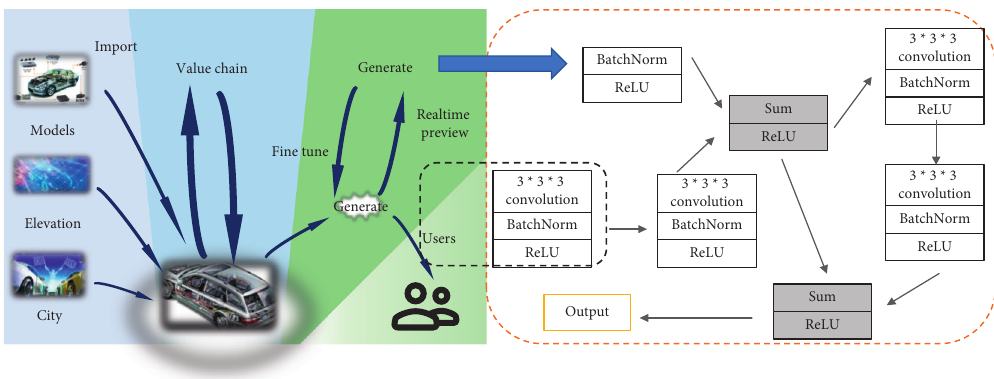
Figure 2: Collaboration of traditional accessory